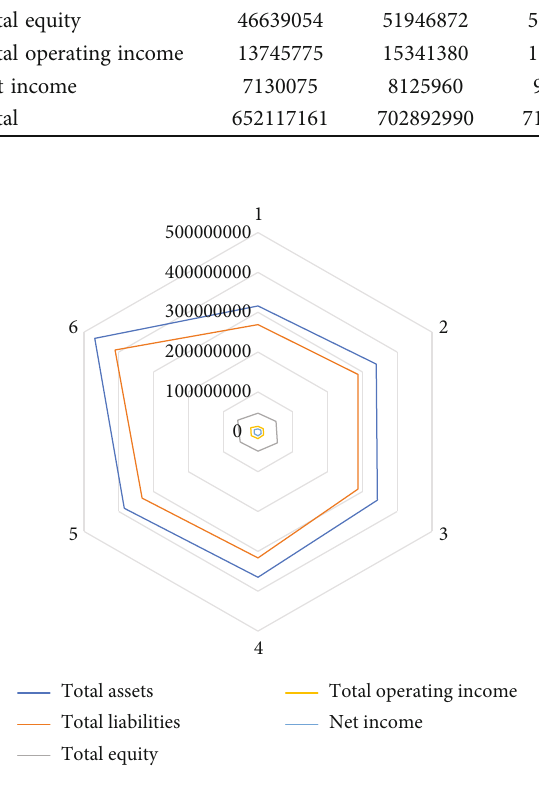
Figure 1: Radar chart of fi nancial